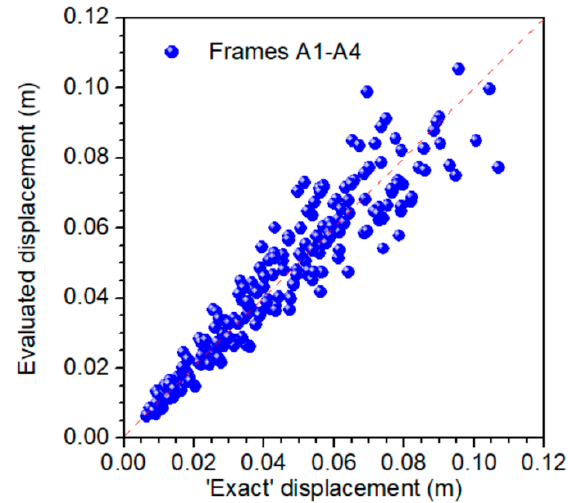
Figure 10. Evaluation of maximum displacements for well-designed frames—Results from 224 dynamic inelastic analyses.